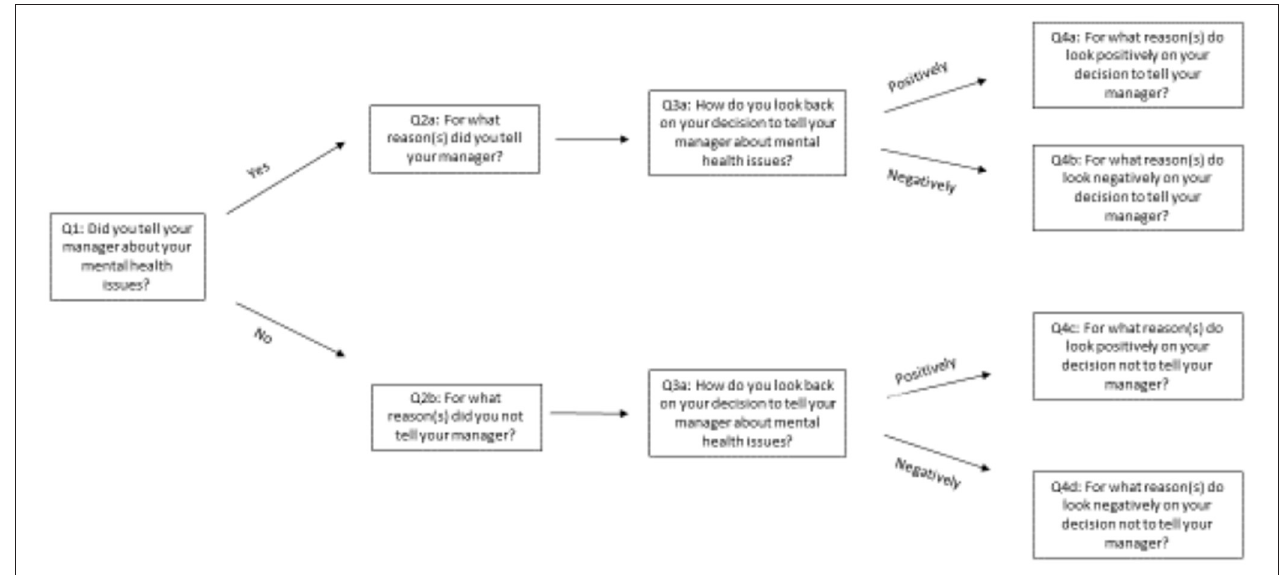
FIGURE 1 | Survey questions